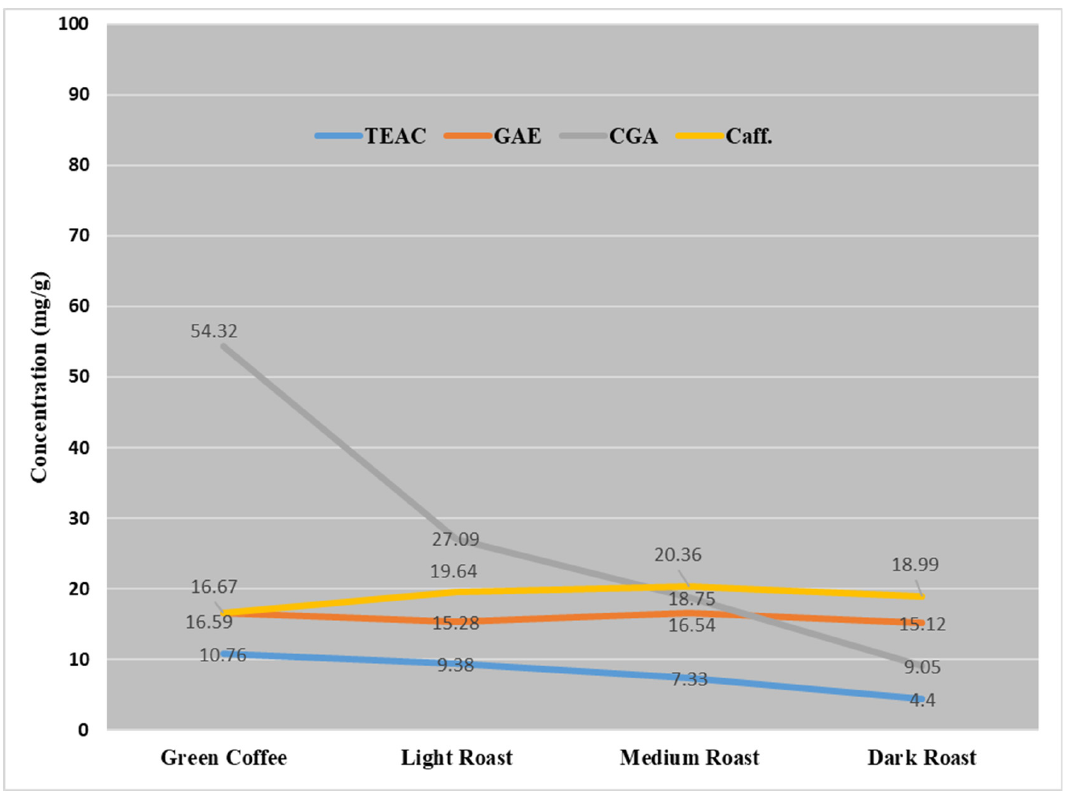
Figure 4. The effect of degree of roasting on the concentration of caffeine, CGA, GAE (total phenols) and TEAC (antioxidants) in coffee beans from different sources.